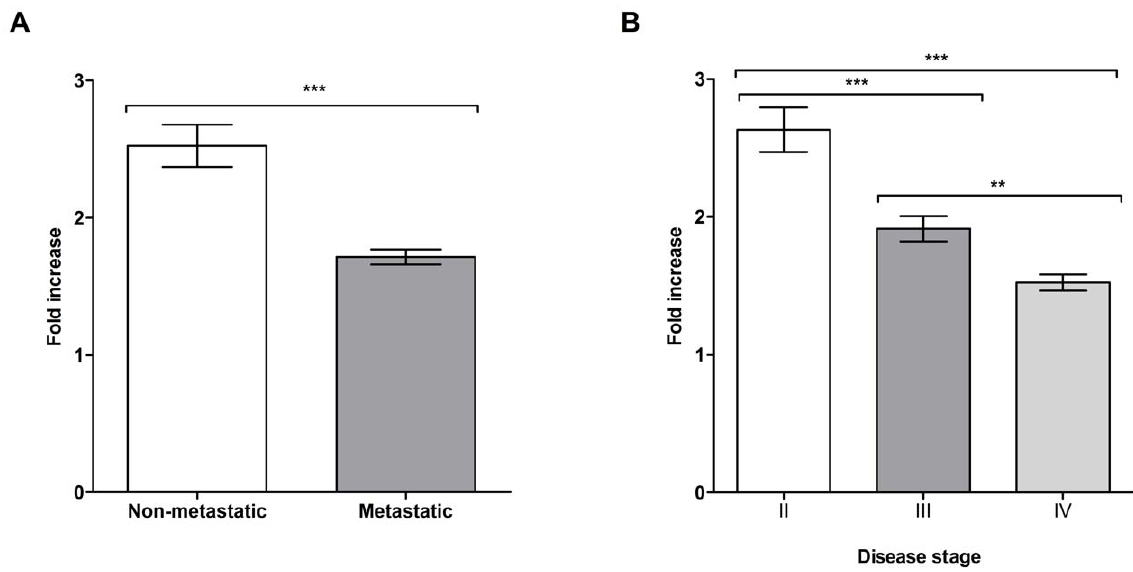
Figure 3. Prevalence of melanoma-reactive antibodies derived from melanoma patient B cell cultures is reduced in advanced disease stages. (A) Comparison of mean antibody culture reactivity to A-375 cells (fold increase relative to negative control human IgG antibody) for patients with localized (non-metastatic, n=9) and metastatic (n=12) disease, P , 0.0001. (B) Mean reactivity to A-375 cells (fold increase relative to negative control antibody) of cultures from patients with stage II (n=8), III (n=6) and IV (n=6) melanoma. Antibody reactivity was determined using a cell-based ELISA. Fold increase values in panels A and B were determined relative to the mean absorbance to a negative control human IgG antibody. *** P , 0.001 and ** P= 0.001 to 0.01. Error bars in figures represent 95% confidence intervals.